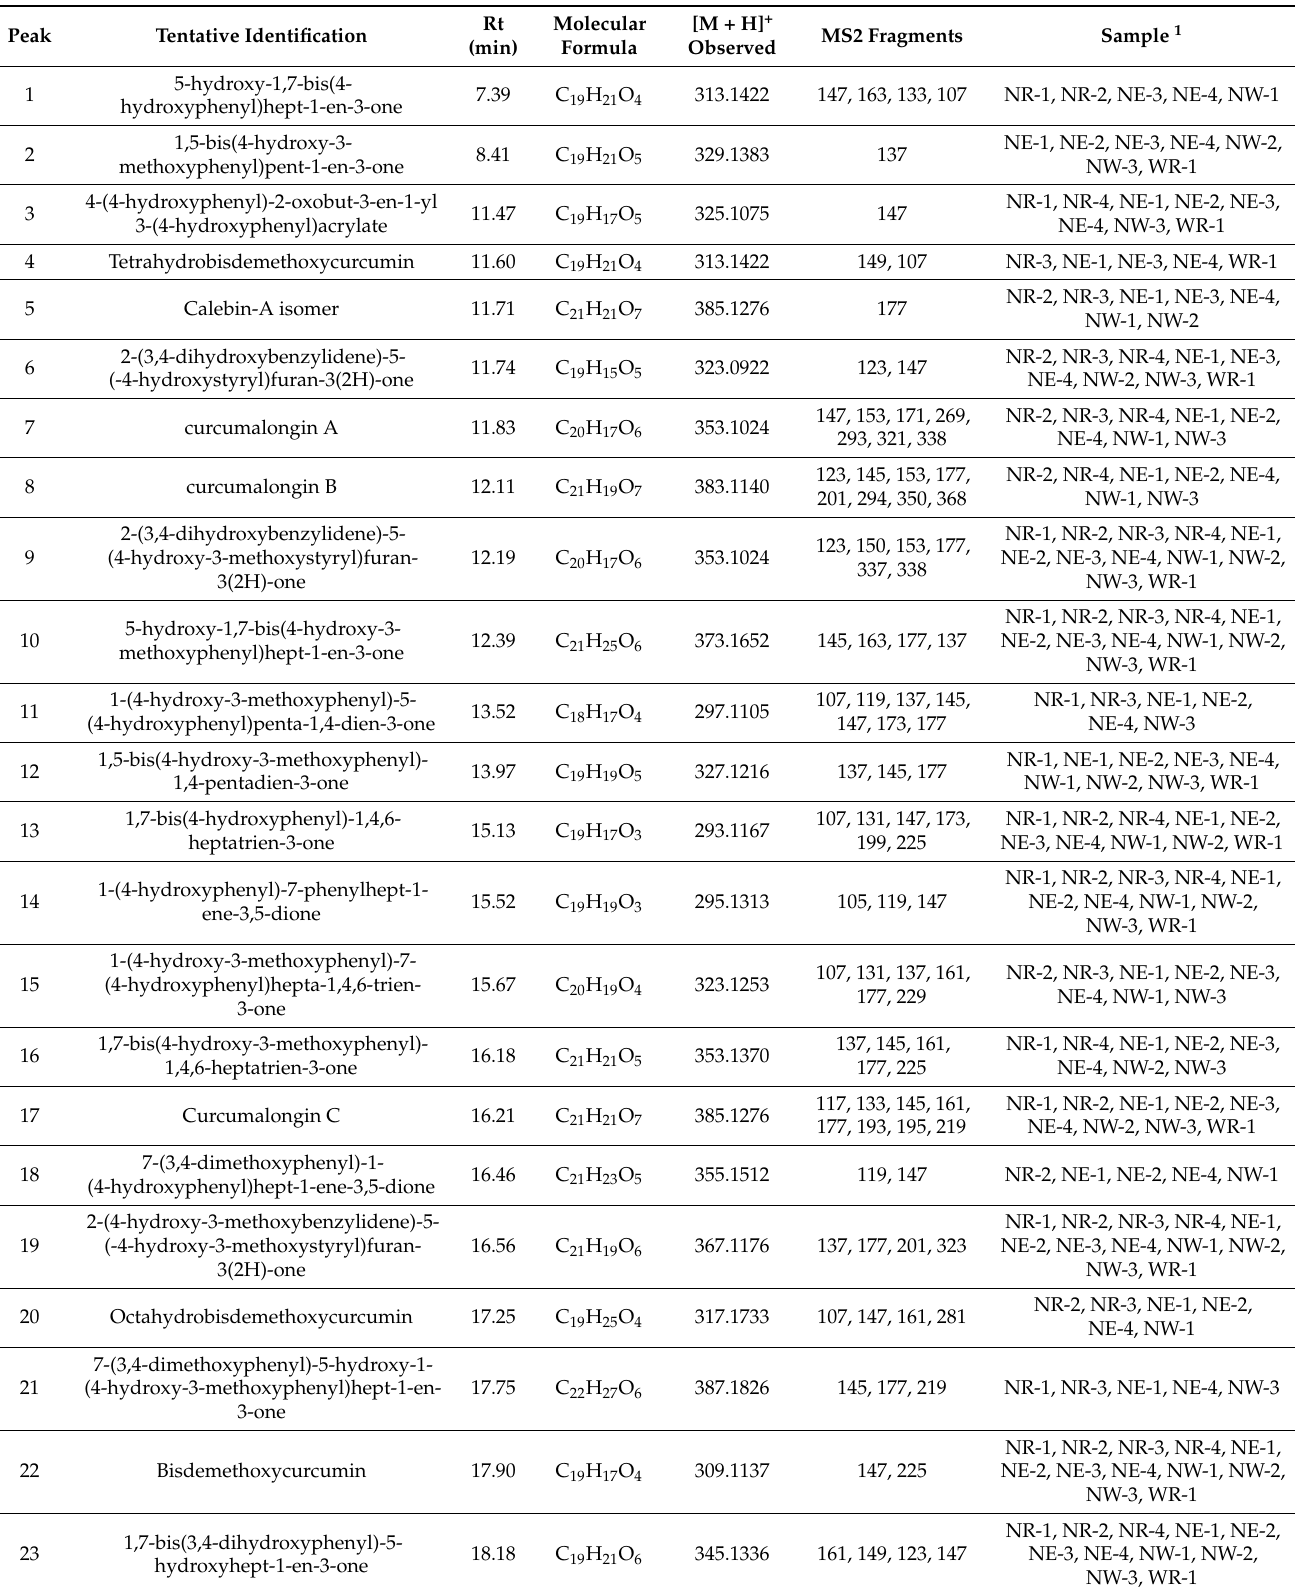
Table 2. Profile of the phenolic compounds identified by UPLC-QTOF-ESI MS in Curcuma longa rhizomes from Costa